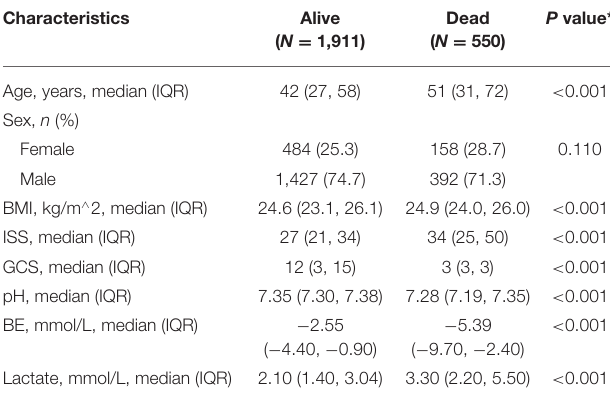
TABLE 2 | Baseline characteristics of patients who died or survived in the training